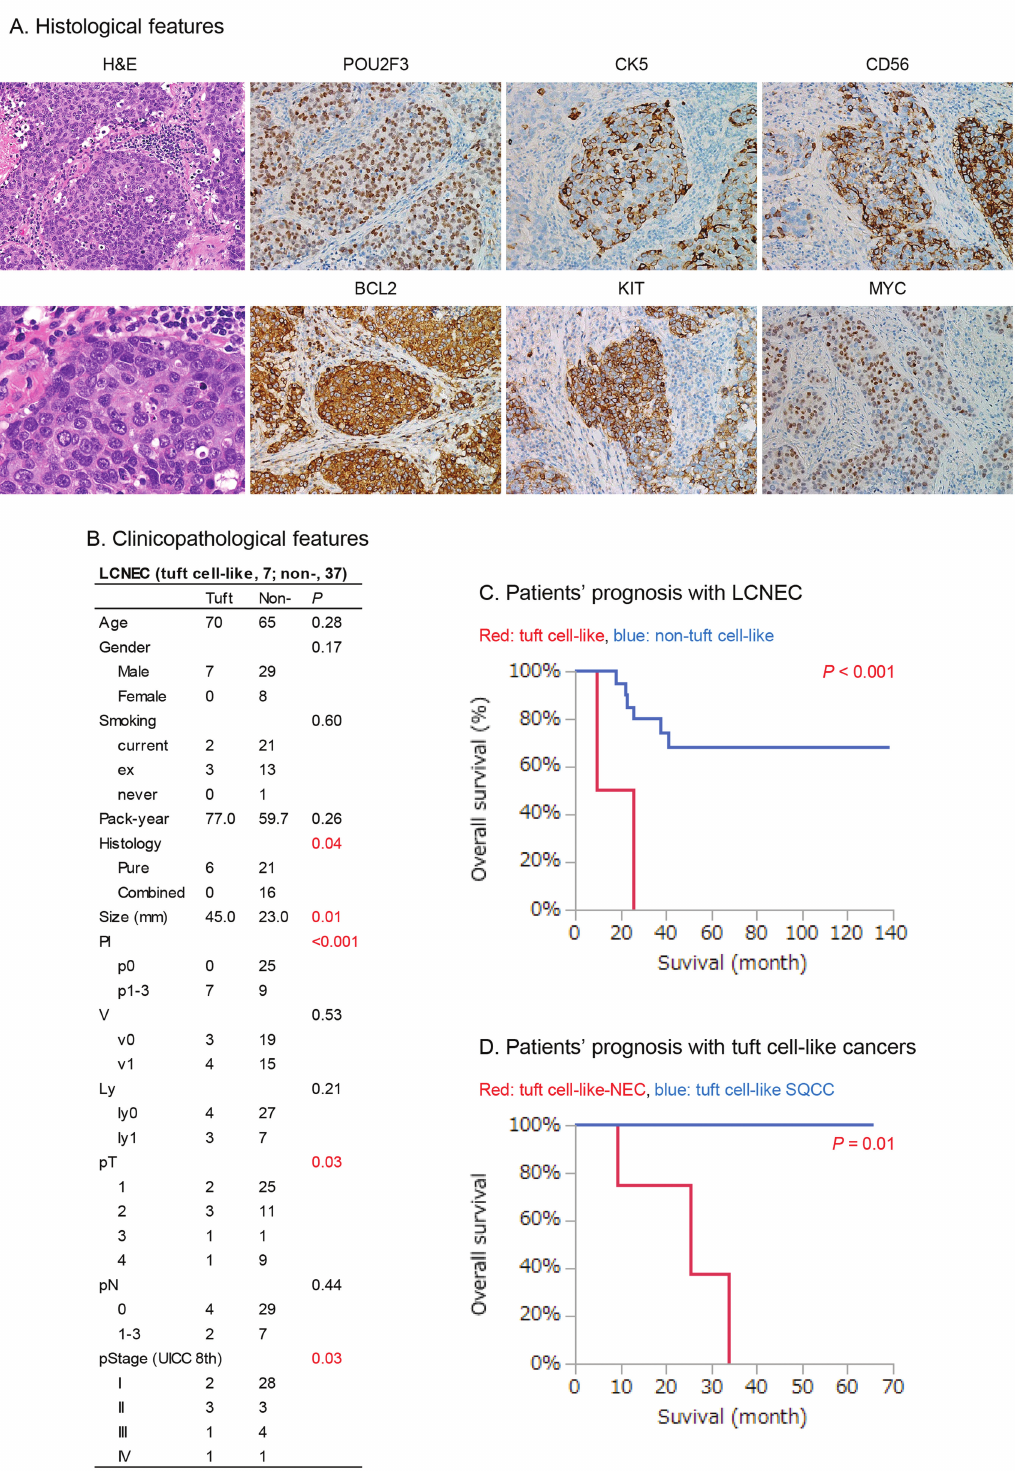
Cell Death and Disease (2022)